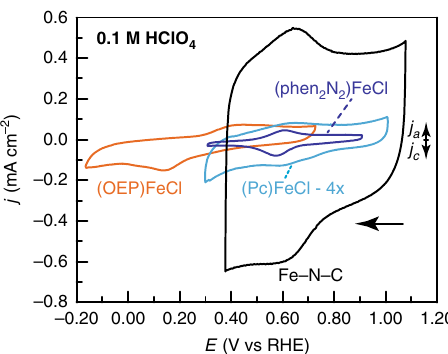
Fig. 5 Cyclic voltammograms of adsorbed catalysts. Rotating glassy carbon disk electrodes are shown modi fi ed with catalyst fi lms containing Fe-N-C (black), (phen 2 N 2 )FeCl (blue), (Pc)FeCl (aqua, 4× vertical expansion), and (OEP)FeCl (orange). Data were recorded at 5 mV s − 1 and 2000 rpm rotation rate in O 2 -free 0.1 M HClO 4